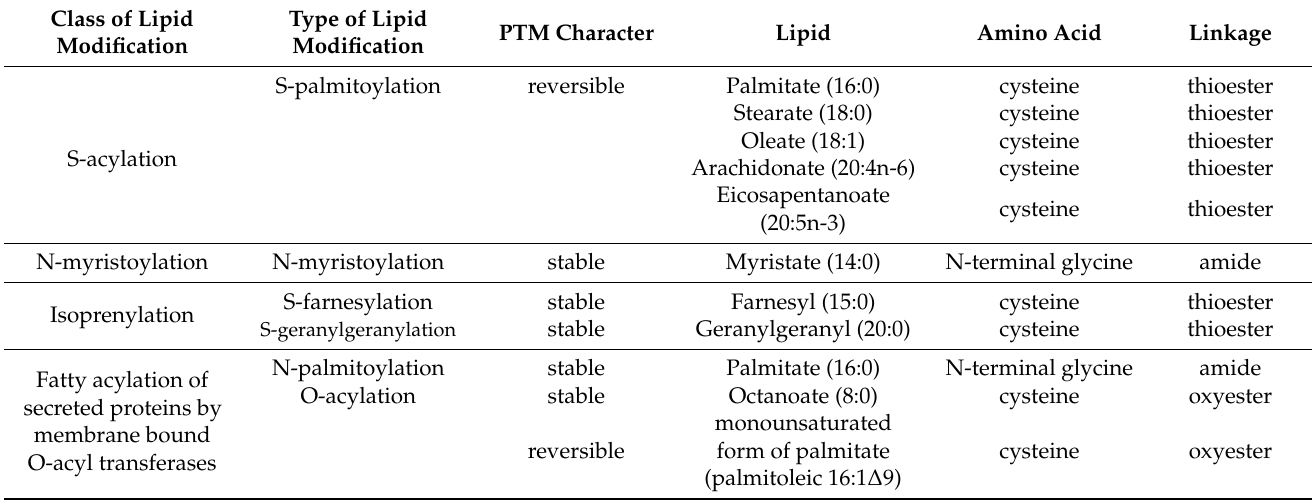
Table 1. Proteins are primary substrates for 4 classes of lipid modifications (which do not represent the whole spectrum of lipid modification): S-acylation, N-myristoylation, isoprenylation, and the fatty acylation of secreted proteins. Every type of lipid modification is catalyzed by unique enzymes and targets a specific amino acid of substrate protein creating characteristic linkage. Most common form of S-acylation is S-palmitoylation. The unique quality of S-palmitoylation is its reversibility, and most lipid modifications create stable